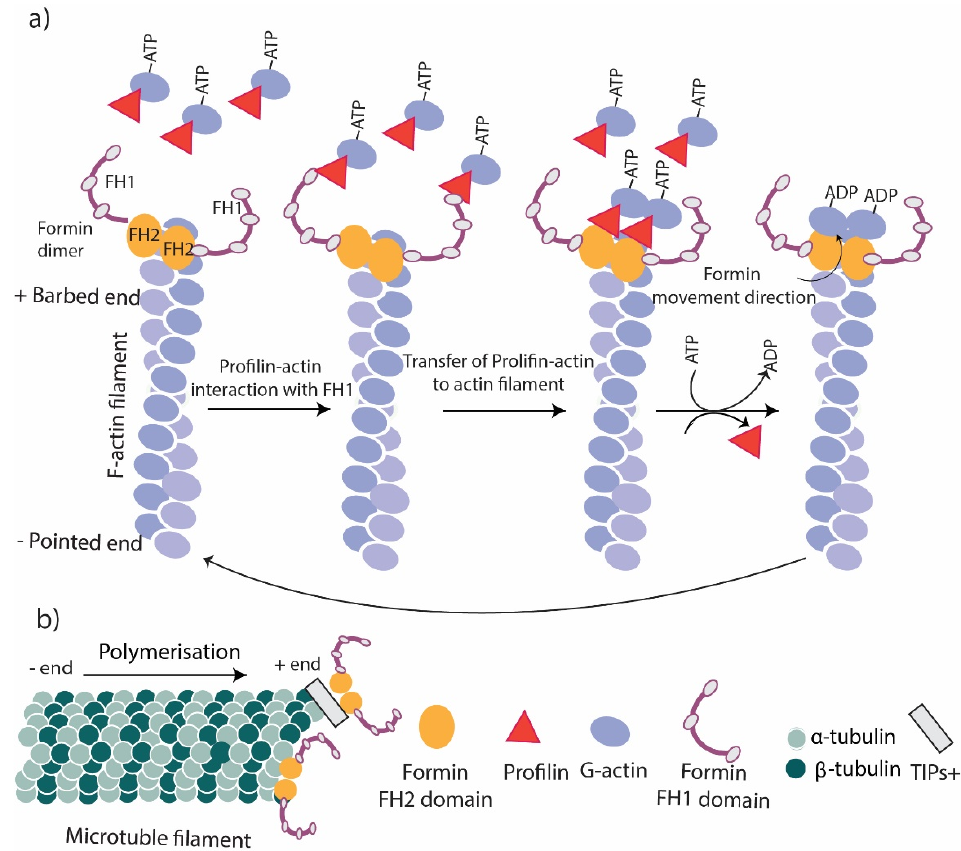
Figure 2. Formins function. ( a ) Actin polymerization. The FH2 domain of formins remains at the barbed end of actin filaments to stabilize and cap the actin filament. The interaction of FH2 with the FH1/profilin complex transfers new G actins to the barbed end of the filament and promotes polymerization. ( b ) Microtubule stabilization. Formins link to the + end of microtubules directly or via their FH2 domain or through TIPs.